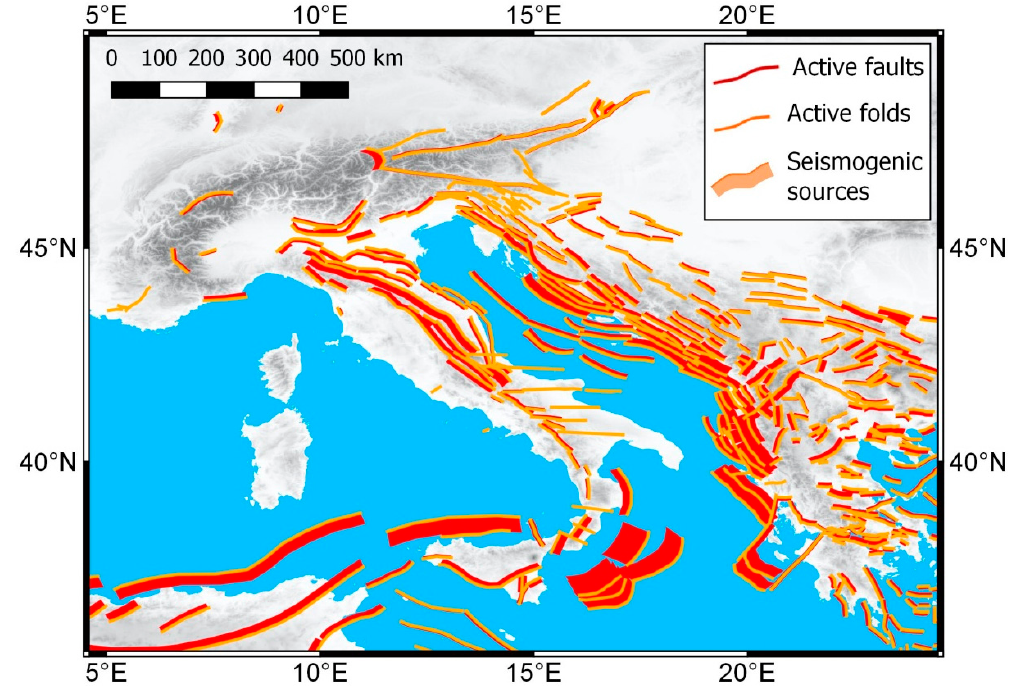
Figure 1. Map of individual seismogenic sources in the Alpine Mediterranean area provided by Database of Individual Seismogenic Sources DISS [25]. Active faults are shown with red lines, active folds in orange. Composite seismogenic sources (formerly seismogenic areas) represented with the coupling of orange and red stripes are based on geological and geophysical data and are characterized by geometric (strike, dip, width, depth) and kinematic (rake) parameters.